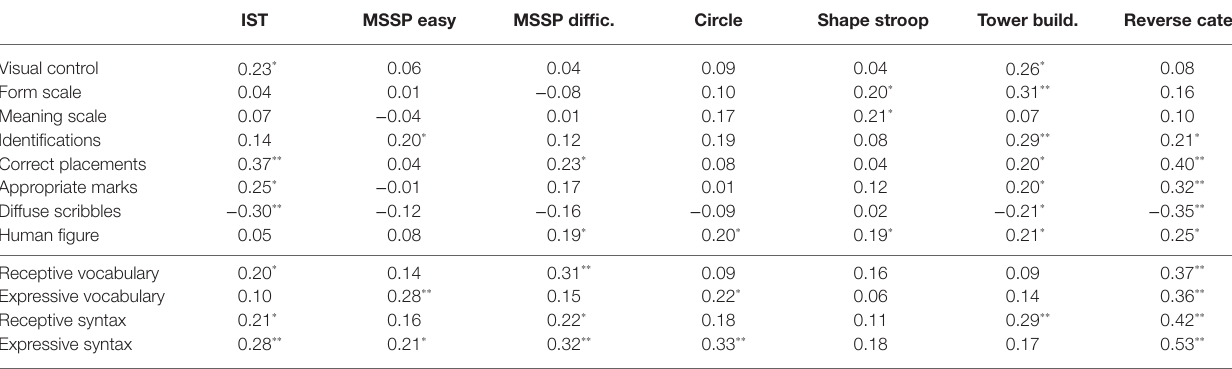
TABLE 8 | Pearson correlations between a language or a drawing measure, and one of the working memory, inhibition, and shifting measures. IST MSSP easy MSSP diffic. Circle Shape stroop Tower build. Reverse categ.